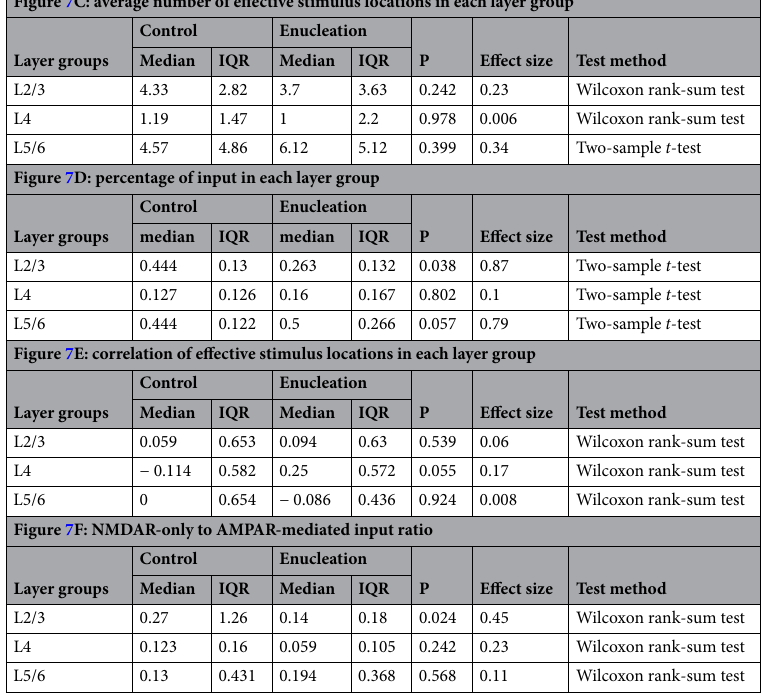
Figure 7C: average number of effective stimulus locations in each layer group